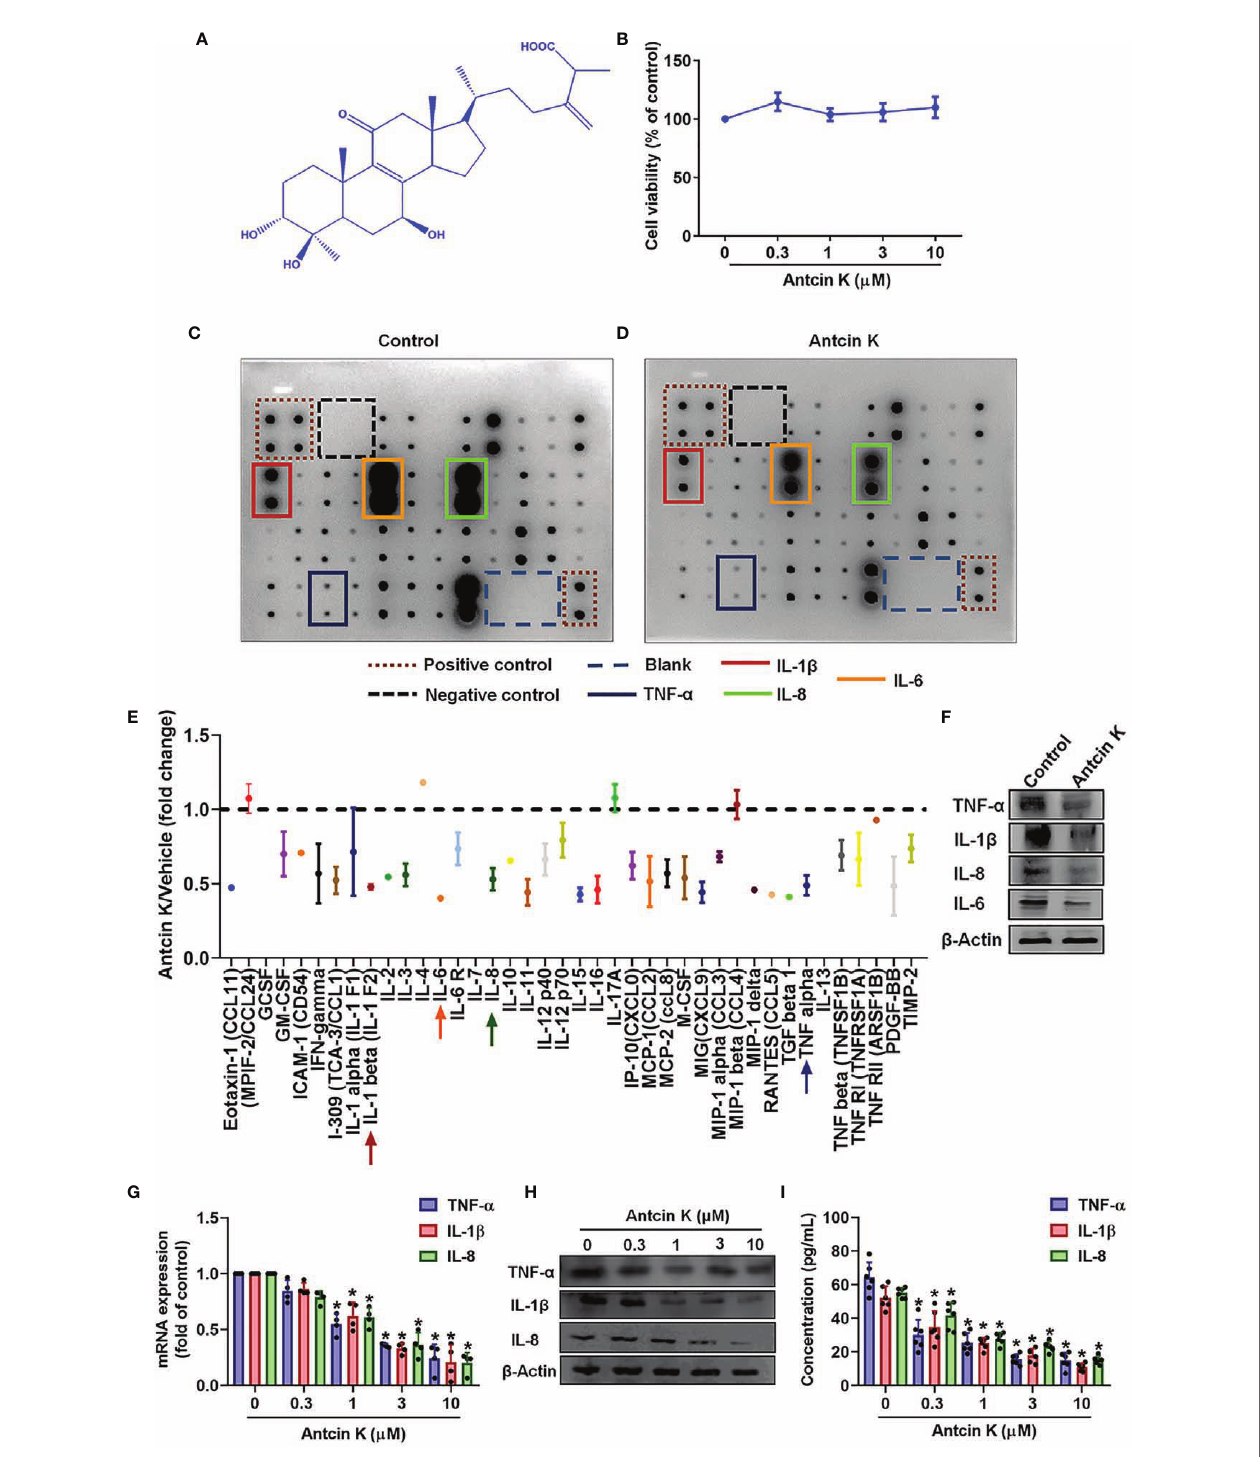
FIGURE 2 | Antcin K inhibits TNF- a , IL-1 b and IL-8 expression in RASFs. (A) Chemical structure of compound Antcin K. (B) Cells were incubated with Antcin K (0.3, 1, 3 or 10 m M for 24 and cell viability was examined by the MTT assay. (C – E) Cells were incubated with Antcin K (10 m M) for 24 h and the expression of 40 in fl ammatory factors was quanti fi ed by a human in fl ammation antibody array. (F) Inhibitory effects of Antcin K on TNF- a , IL-1 b , IL-6, IL-8 and protein secretion were evaluated by Western blot. (G – I) Cells were incubated with Antcin K (0.3, 1, 3 or 10 m M) for 24 h. TNF- a , IL-1 b and IL-8 mRNA expression and protein secretion were evaluated by qPCR, Western blot, and ELISA. Results are expressed as the mean ± SD. * P < 0.05 compared with